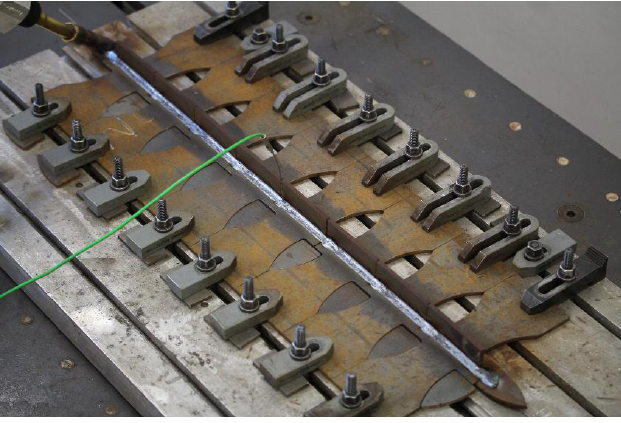
Figure 1. Overview of weld setup including t 8/5 -measurement.